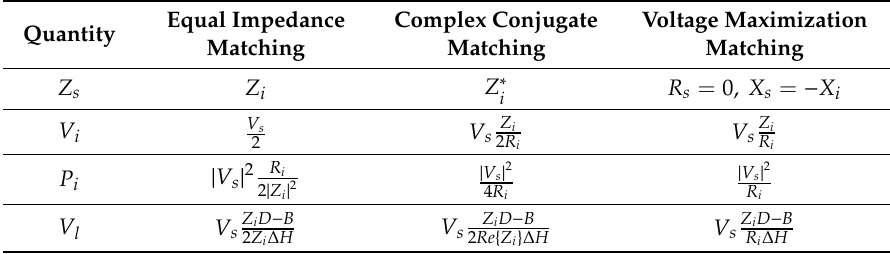
Table 1. Performances of three impedance matching methods